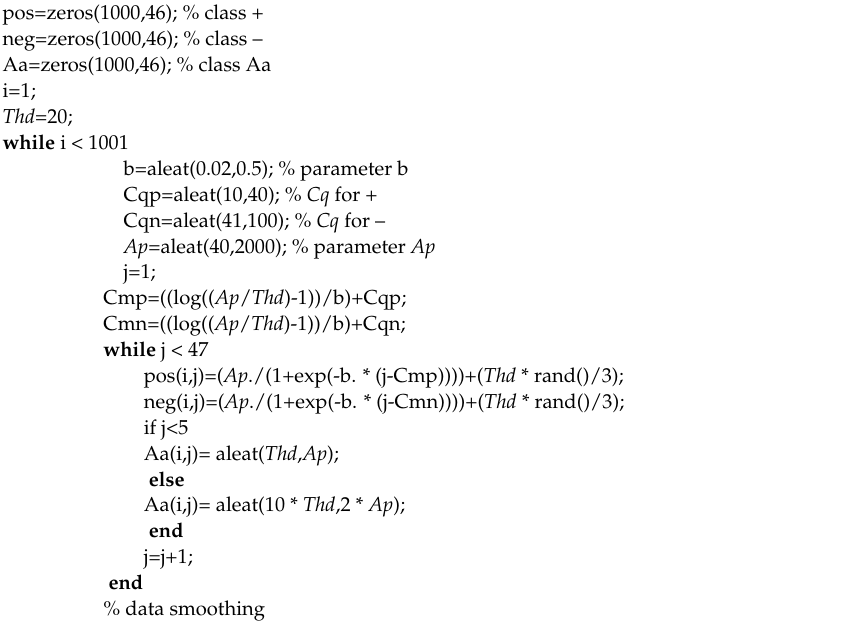
Algorithm 3 Simulation Algorithm Using Random Function